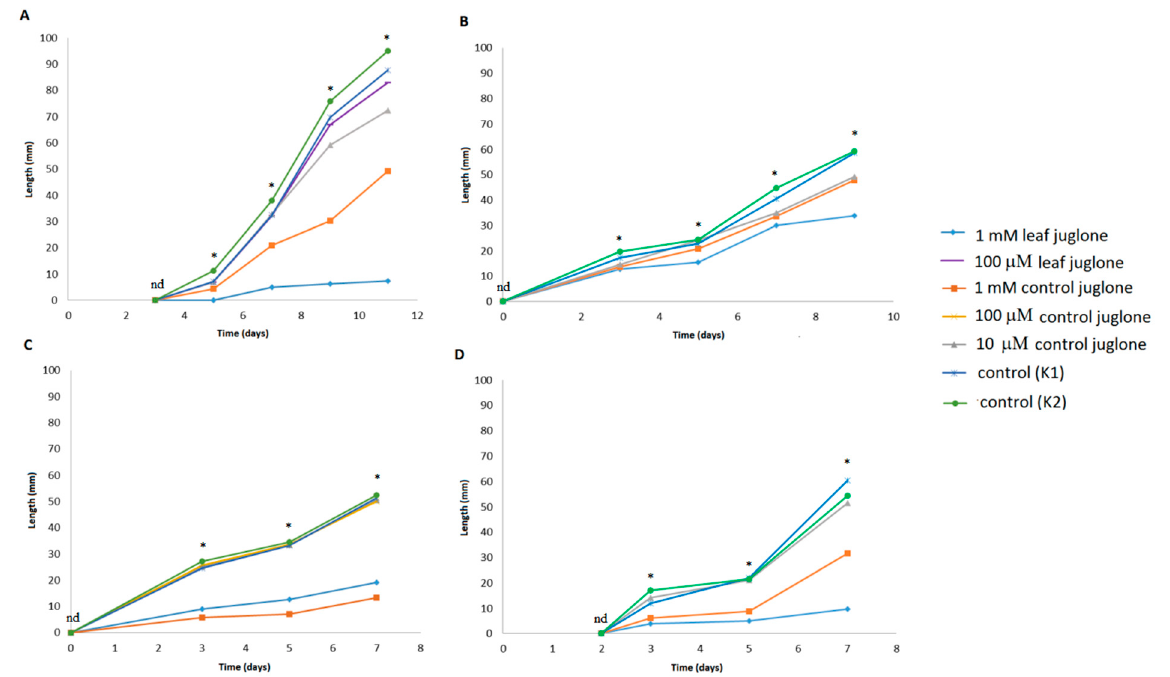
Figure 2. Effects of control juglone and known leaf extract juglone treatments on the overall lengths of the seedlings of S. lycopersicum ( A ), L. culinaris ( B ), L. sativa ( C ) and B. rapa var. japonica ( D ). K1, extraction medium (vehicle); K2, water; *; are significantly different ( p < 0.05); nd, not significantly different.